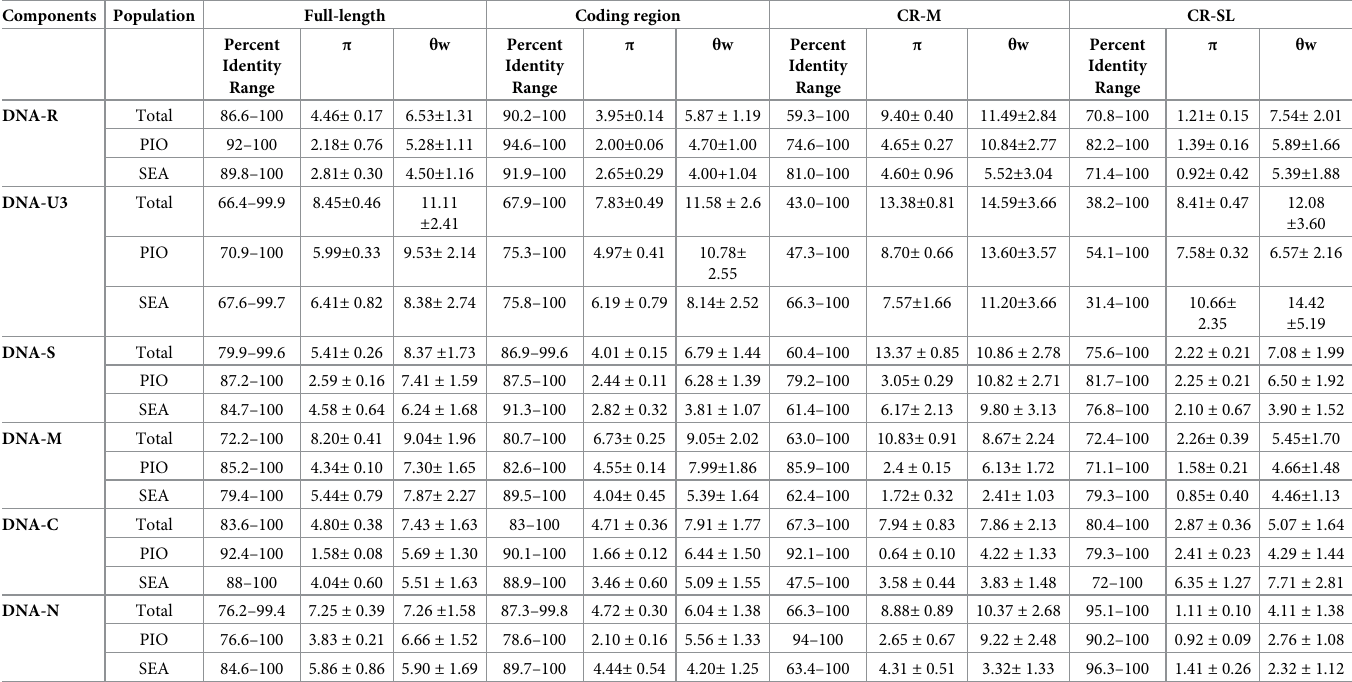
Table 4. Genetic diversity of Banana bunchy top virus population in the world. Components